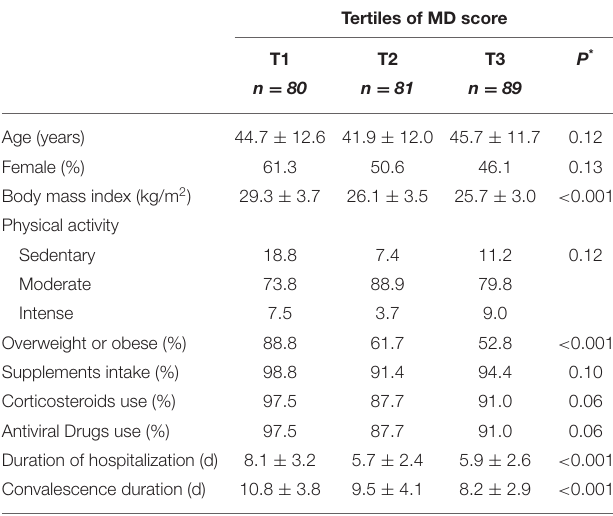
TABLE 1 | General characteristics of participants across tertiles of Mediterranean diet.